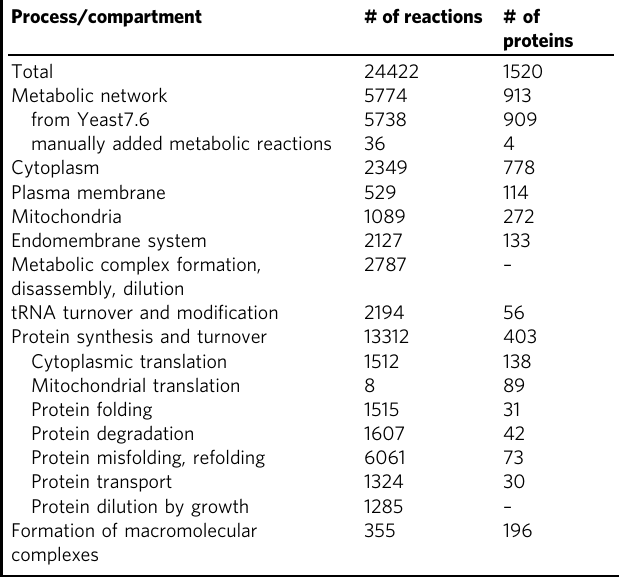
Table 1 Statistics of the pcYeast model.